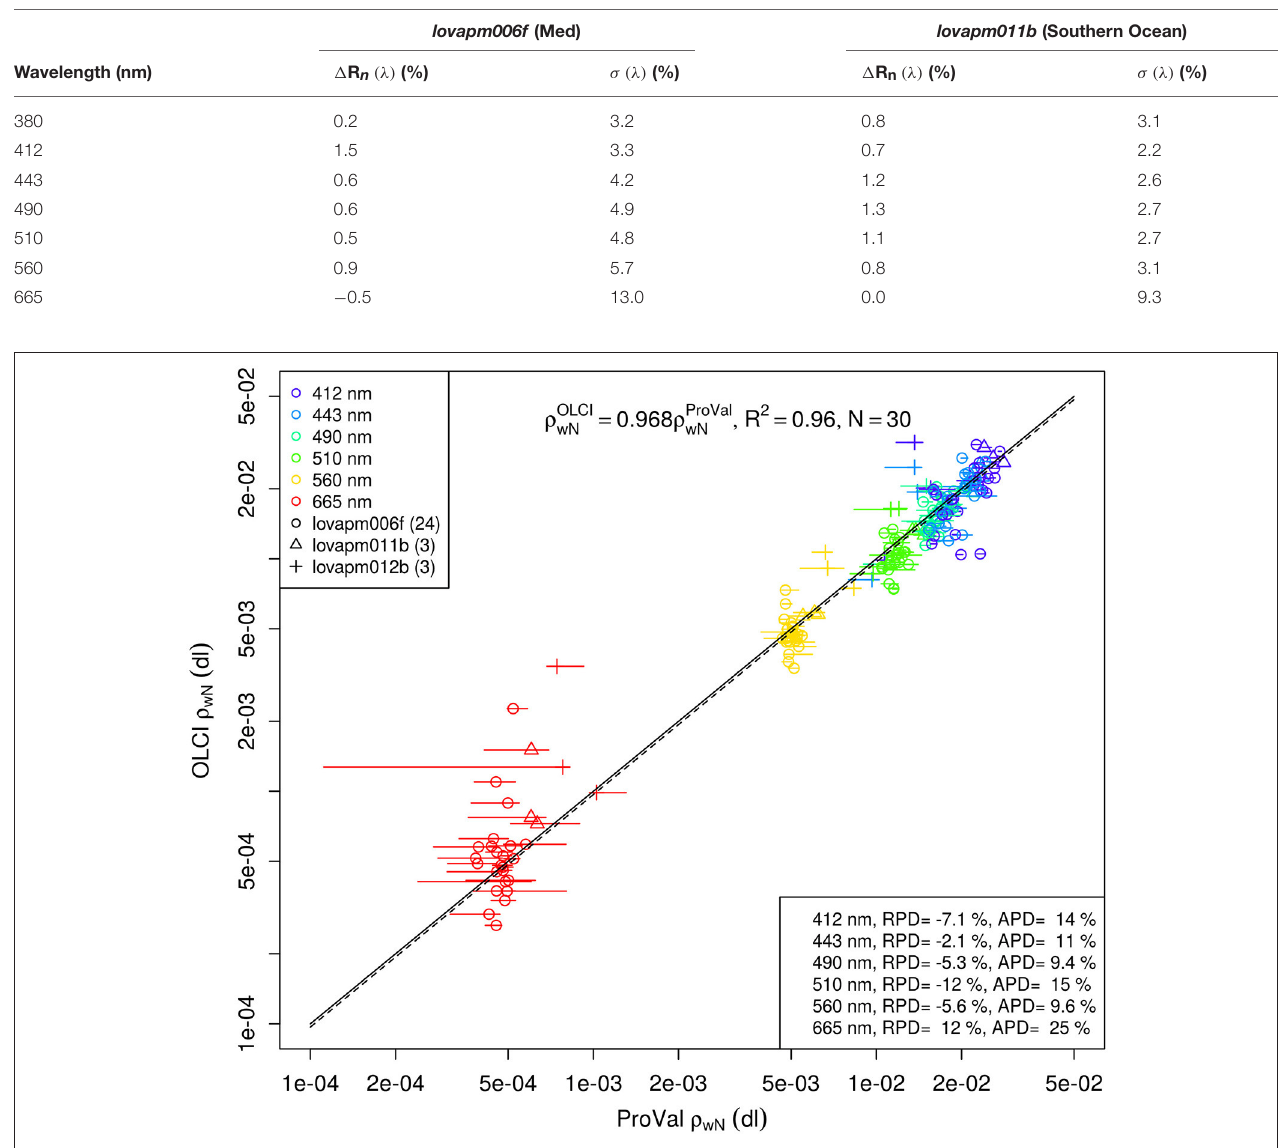
TABLE 5 | Average of the normalized R rs difference and standard deviation of R rs normalized values for all profiles of floats lovapm006f and lovapm011b .